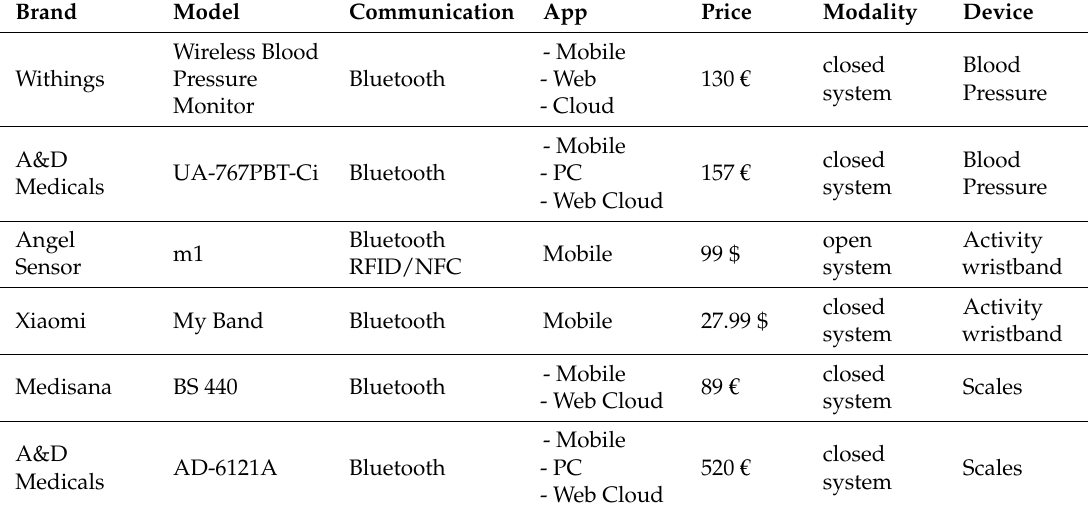
Table 1. Devices used to control hypertension